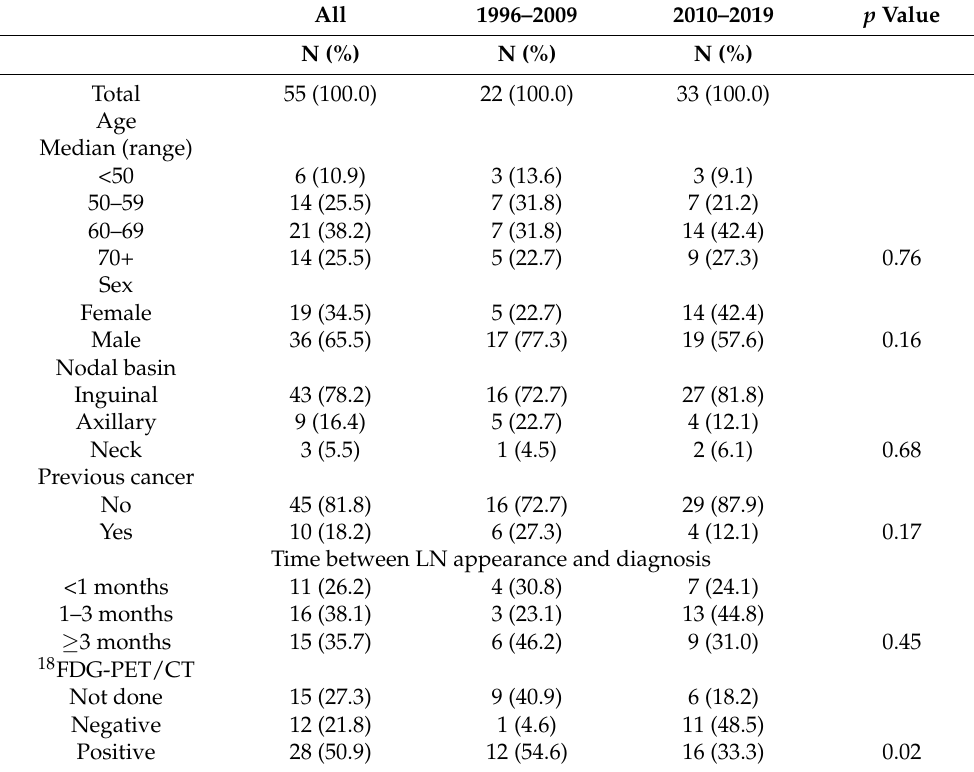
Table 1. Characteristics and diagnostic workup of patients with